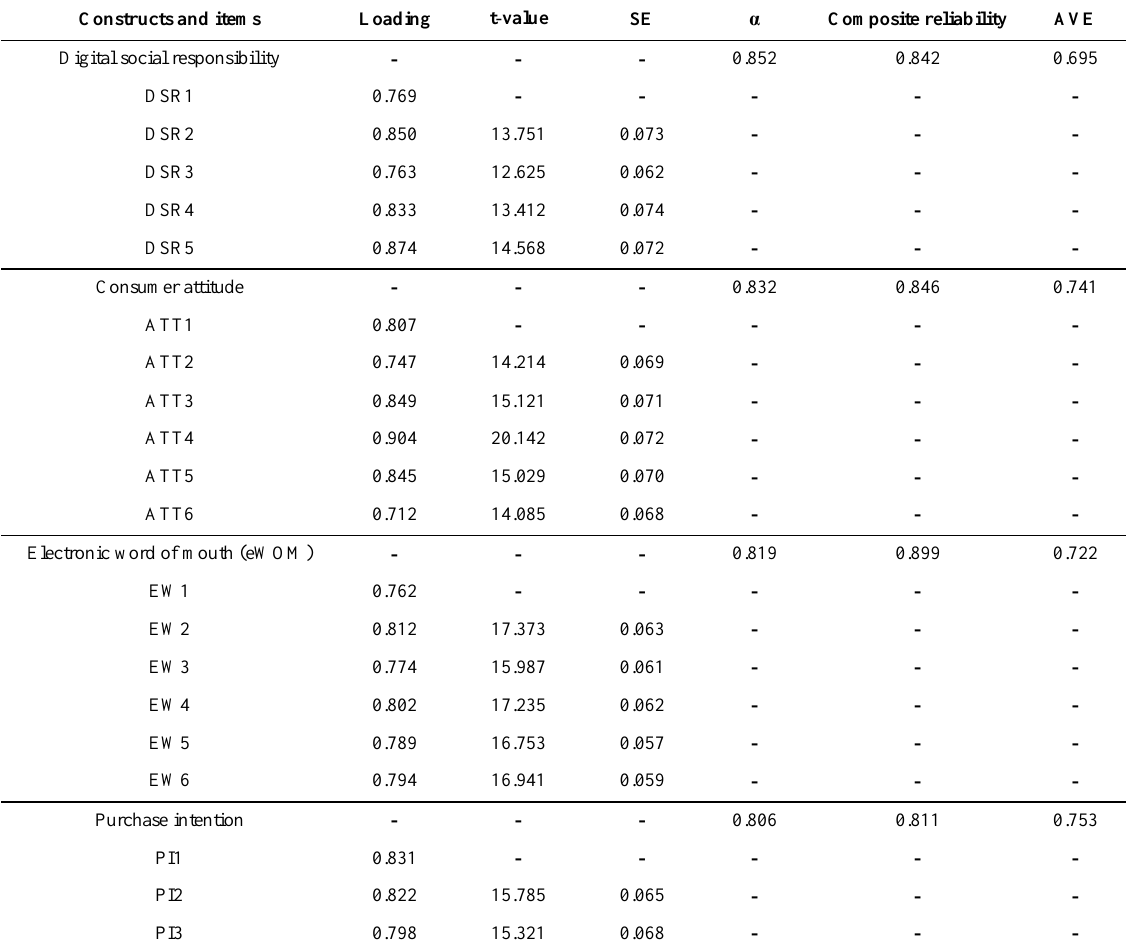
Table 3. Summary of measurement results